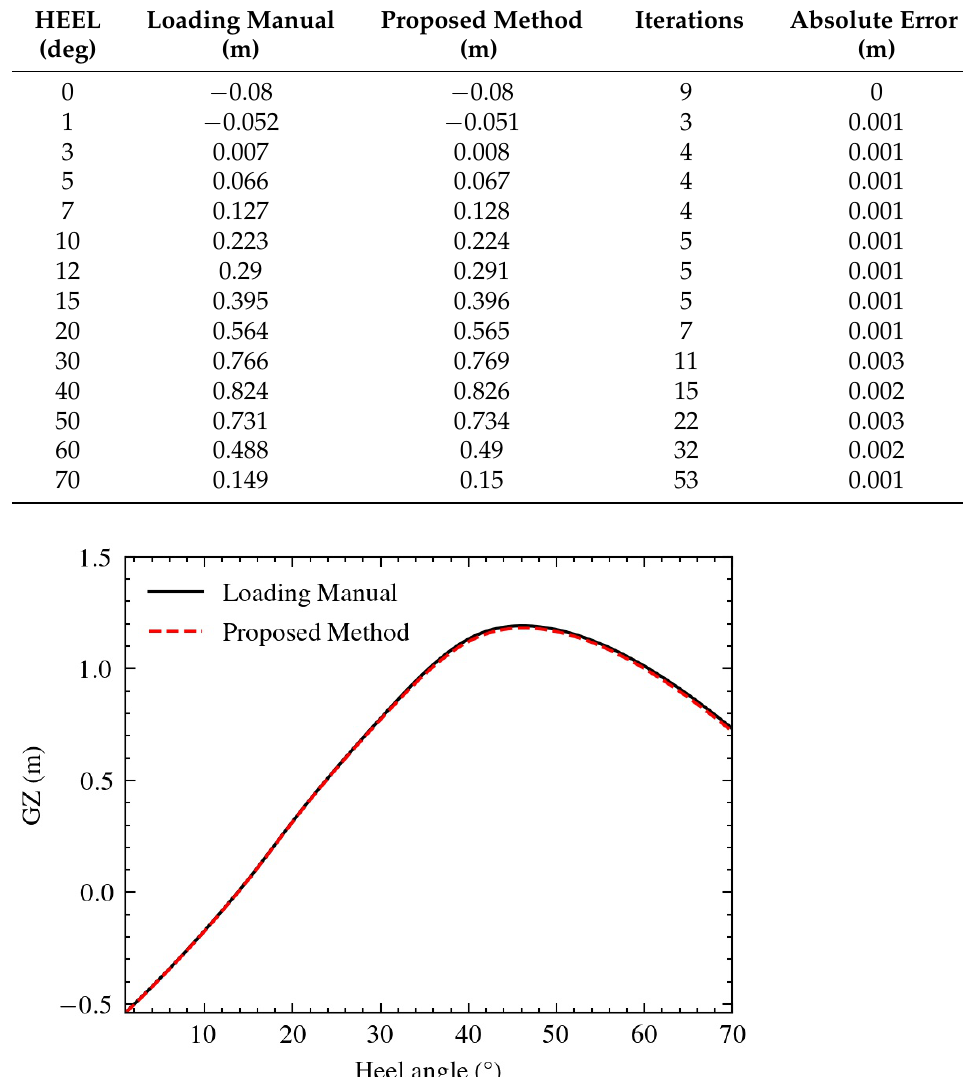
Table 11. GZ calculation result of INI11-DAM04.